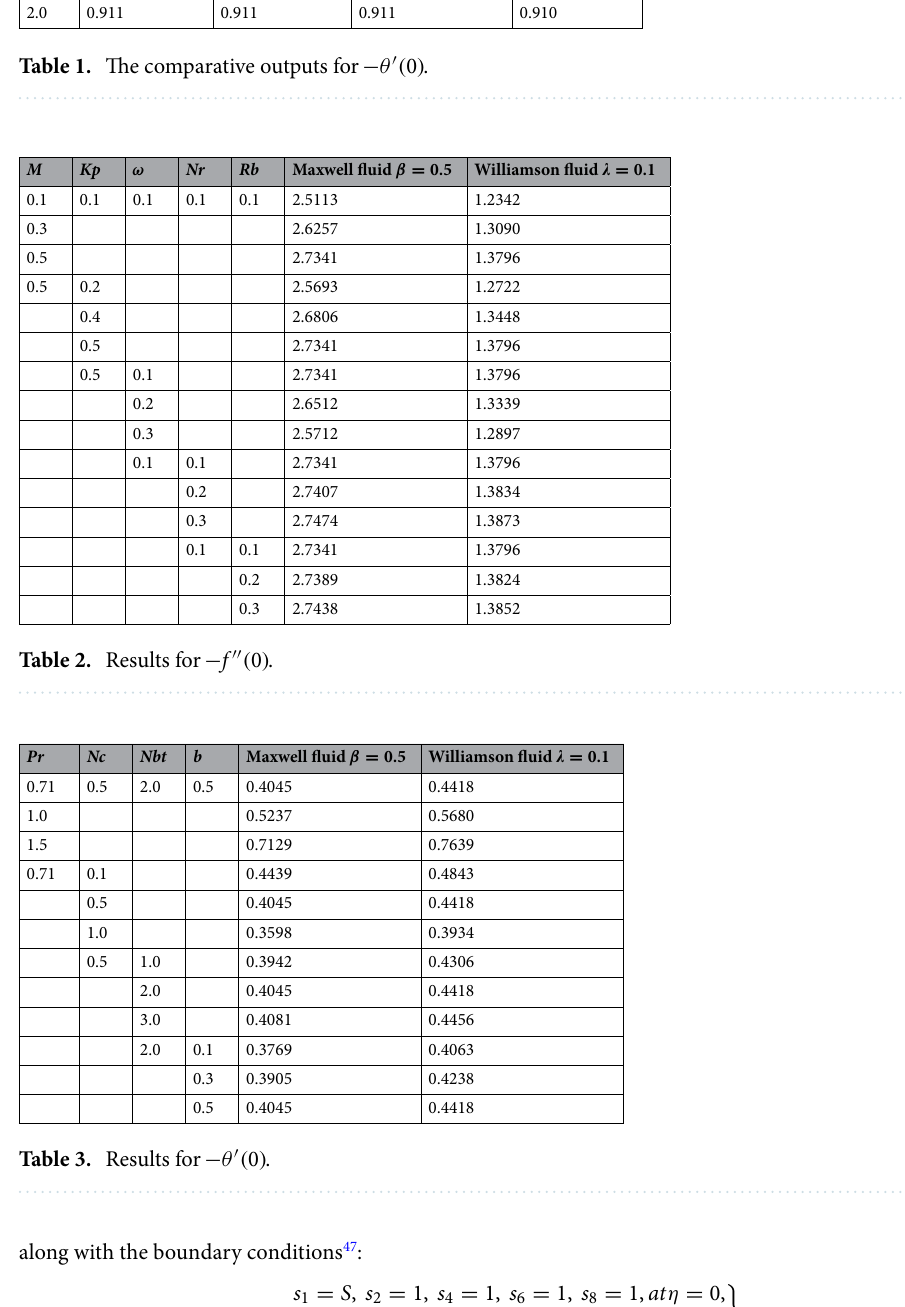
Table 3. Results for